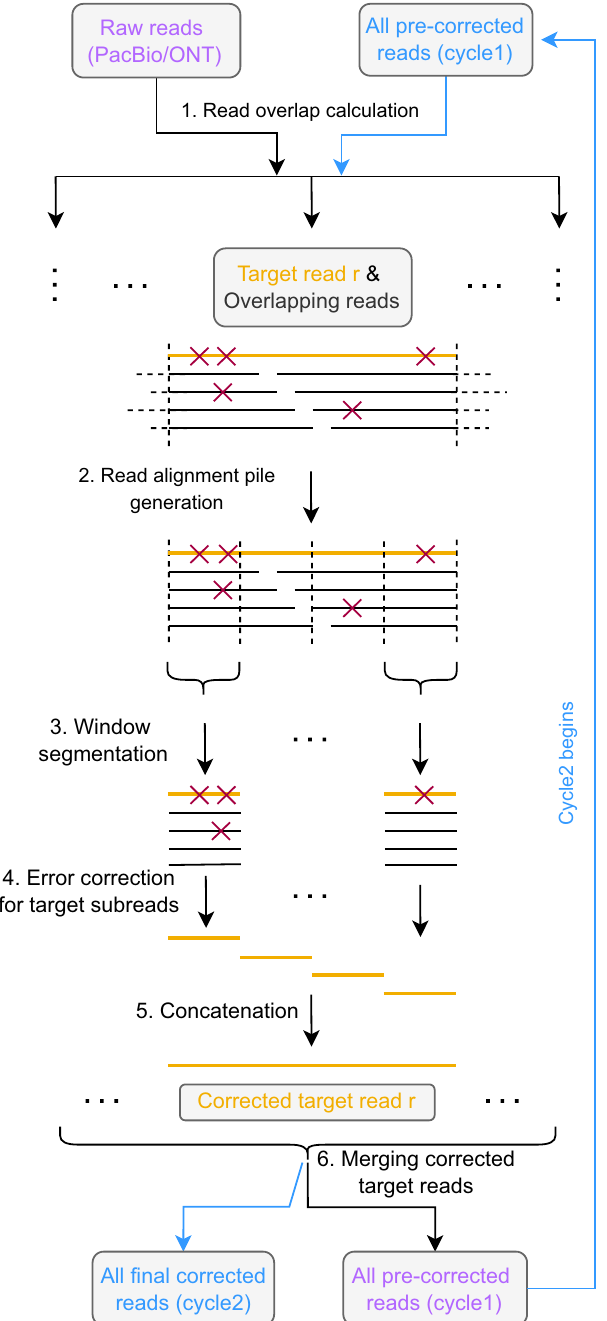
Fig.1|Work fl owofVeChat. Theinputandoutputofcycle1andcycle2arelabeled with purple and blue, respectively. Both cycle 1 and cycle 2 share the steps 1-6 exceptsomedifferencesinstep1and4.Thetargetreadishighlightedwithorange. Red forks indicate the sequencing errors in